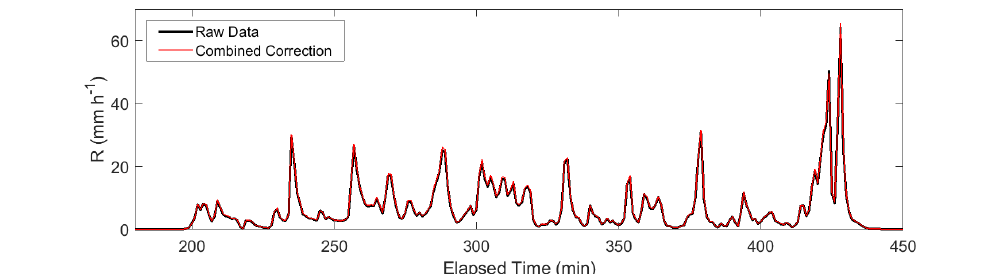
Figure 8. Rain Rate (based on 1 min time-binning) for 2DVD SN074 on 18 February 2020. The “combined correction” incorporates both removal of the spurious drops and the adjustment of the detector